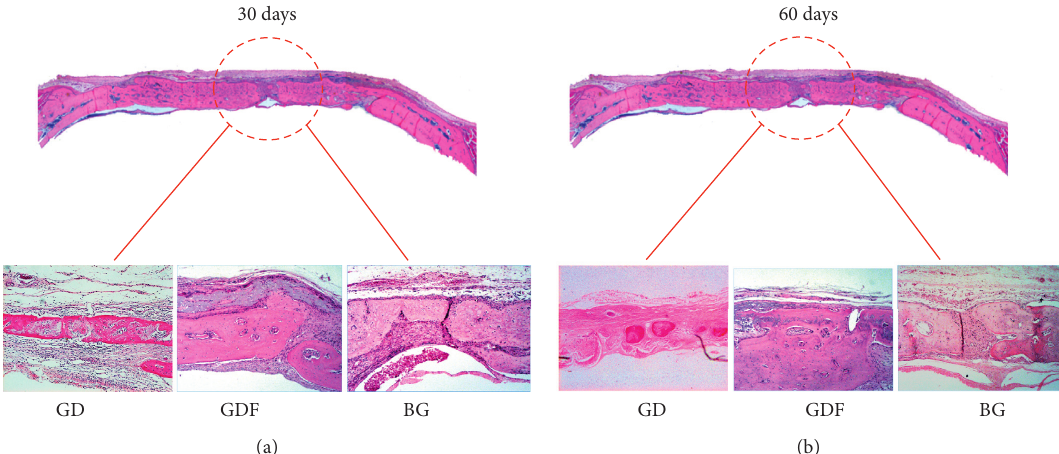
Figure 3: Panoramic histological hematoxylin and eosin-stained section. The images below show the central area of the GD, GDF, and BG groups. Original magnification, × 25 at 30 (a) and 60 days